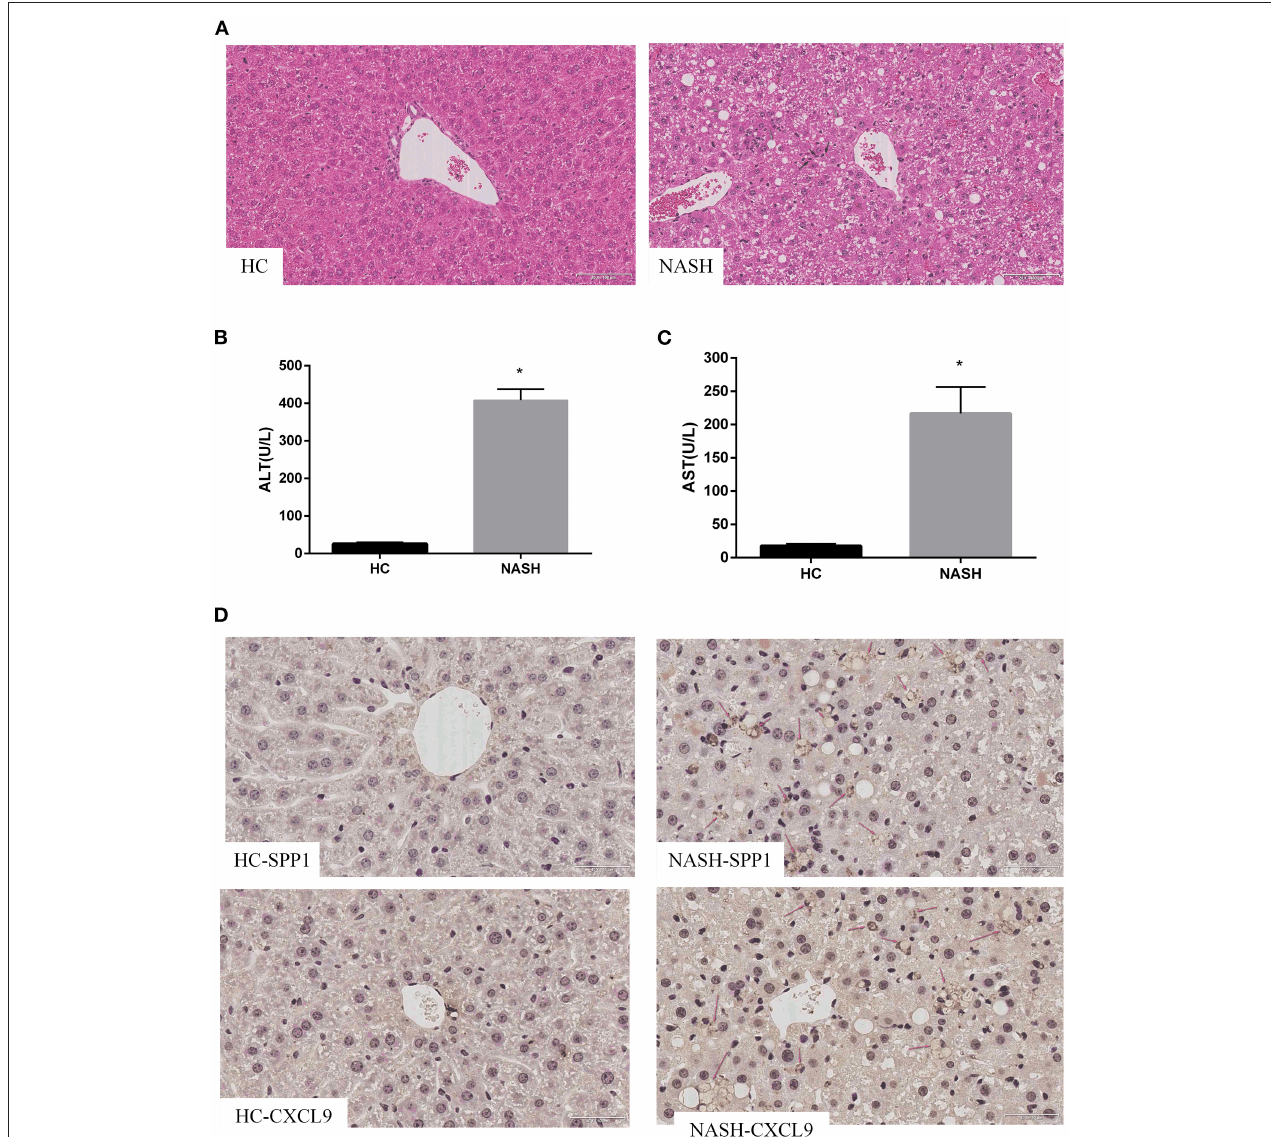
FIGURE 4 | Expression of SPP1 and CXCL9 in MCD diet mice. Serum biochemical indices change, morphological analysis and immunohistochemistry images of the expression of SPP1 and CXCL9 in NASH and HC group of mice liver samples after MCD diet treatment for 8 weeks. (A) The liver samples were stained with hematoxylin–eosin (20 × ) in NASH and HC groups. The gray arrows represent steatosis, the red arrows represent hepatocyte ballooning degeneration, and the black arrows represent lobular infiltration. (B,C) Serum content of ALT and AST changes after MCD diet treatment for 8 weeks. ALT and AST concentrations were significantly higher in NASH group than those in HC group. n = 3, * P < 0.05 compared with HC group. (D) Determination of the expression levels of SPP1 and CXCL9 in NASH and HC group of mice liver samples using immunohistochemical staining (40 × ). The red arrows represent SPP1 or CXCL9 proteins in liver